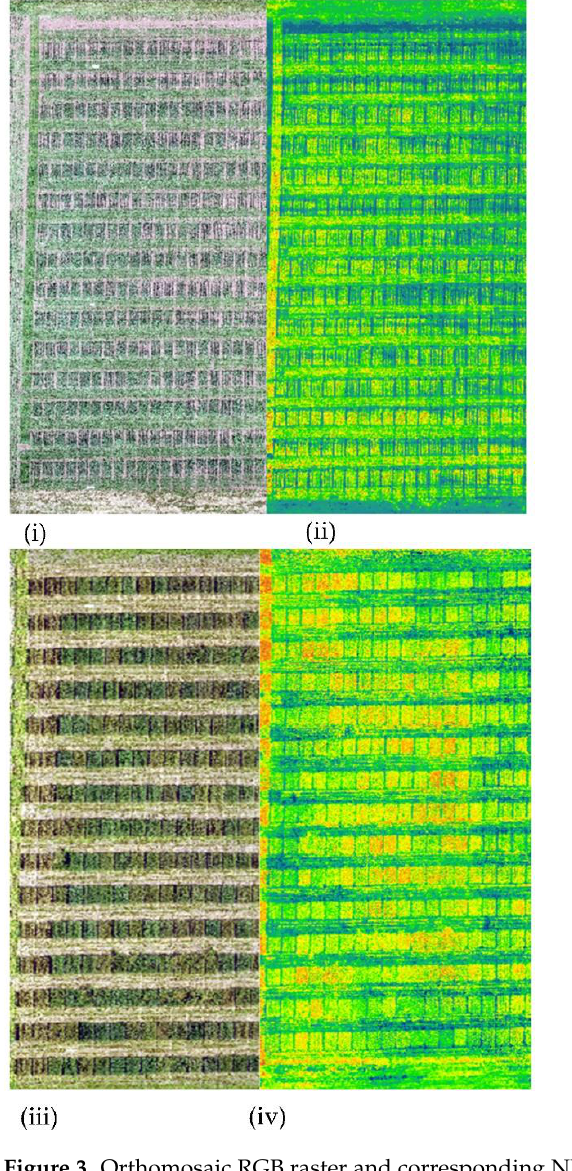
Figure 3. Orthomosaic RGB raster and corresponding NDVI map obtained during first flight ( i , ii ) and last flight ( iii , iv ).